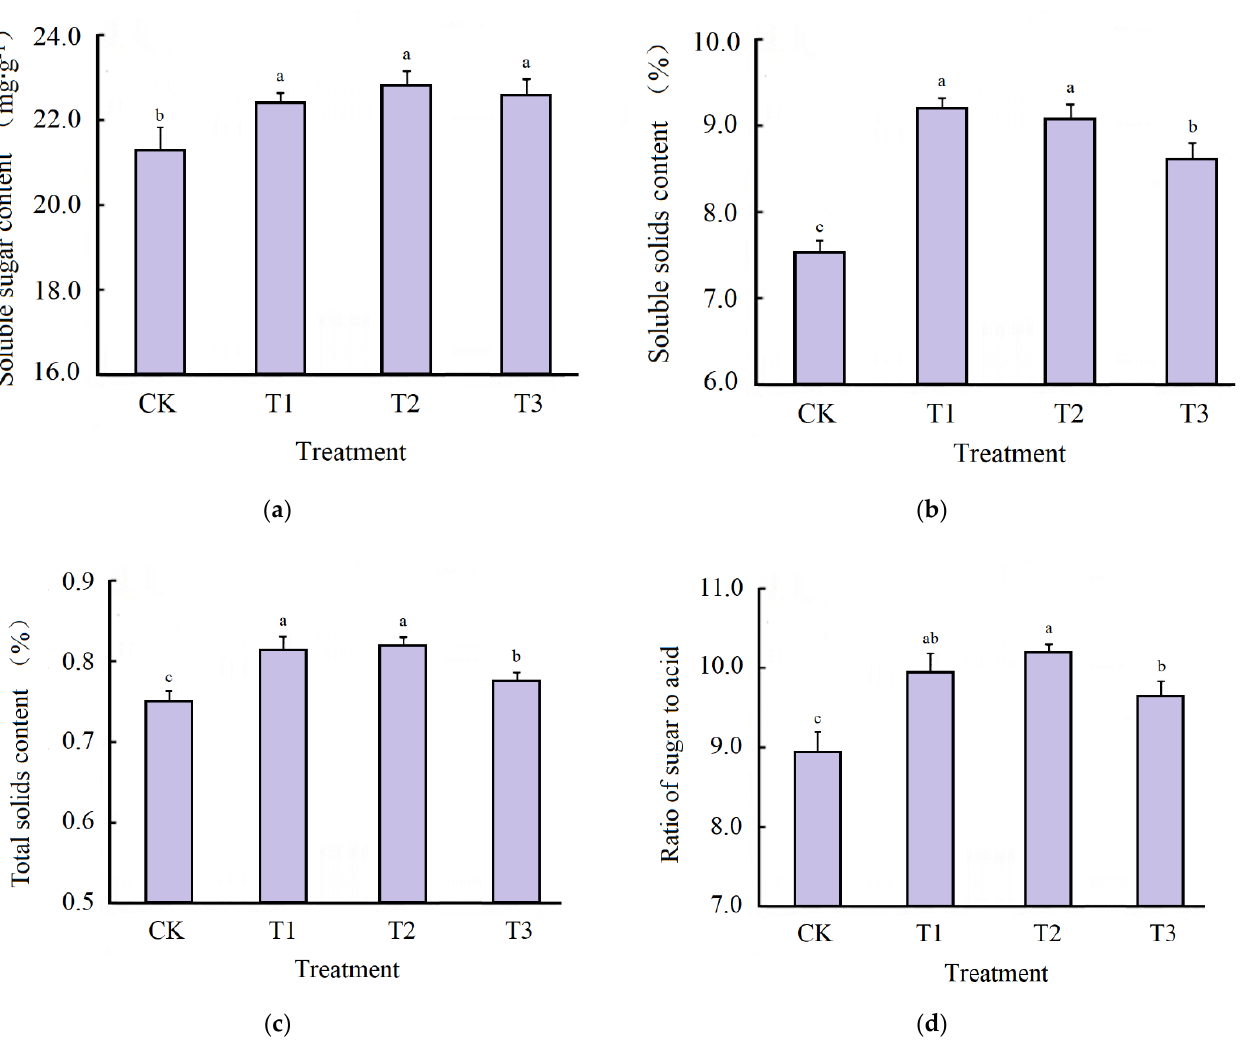
Figure 4. Effect of different abaxial leafy supplemental lighting treatments on flavor quality of cherry tomato. ( a ) Soluble sugar; ( b ) soluble solids; ( c ) total acid; ( d ) ratio of sugar to acid. Tukey’s HSD test was used, and vertical bars represent standard errors of the means ( n = 15). Different letters indicate significant differences at p < 0.05 according to Tukey’s HSD test.